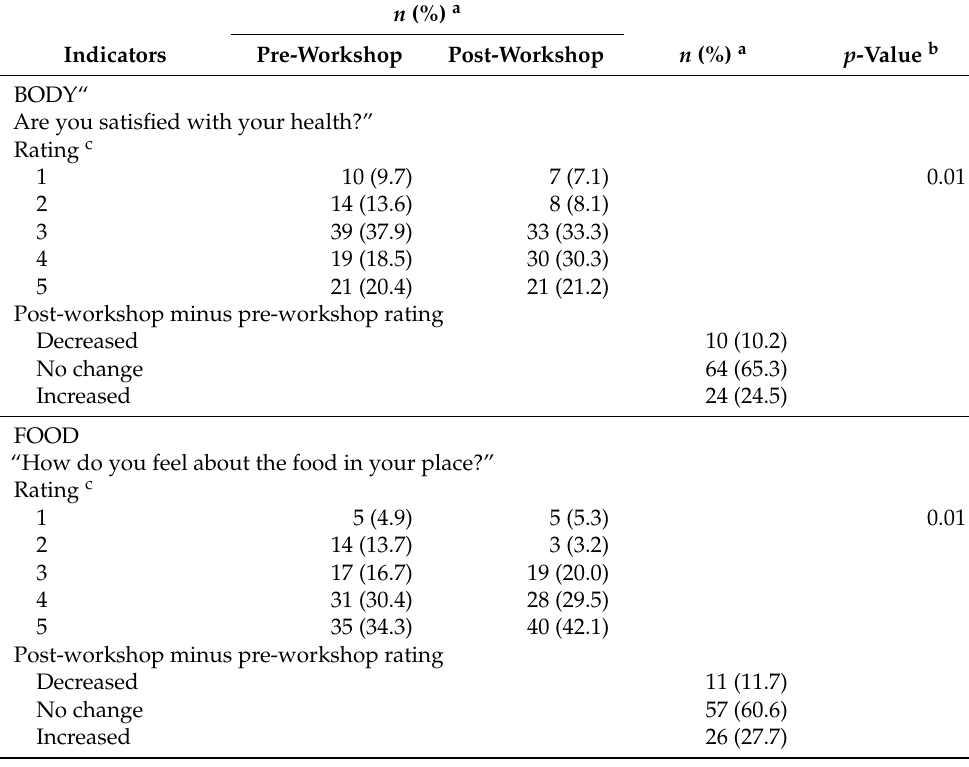
Table 3. Changes in workshop evaluation